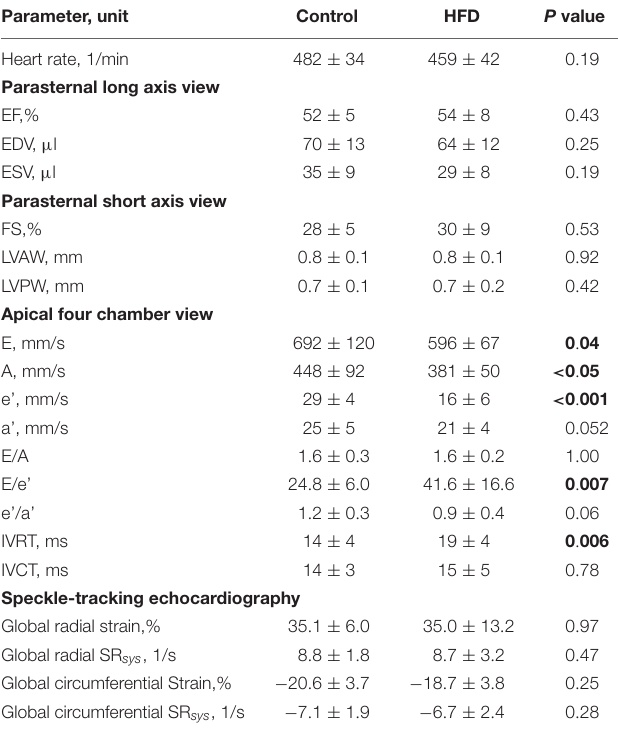
TABLE 2 | Echocardiography